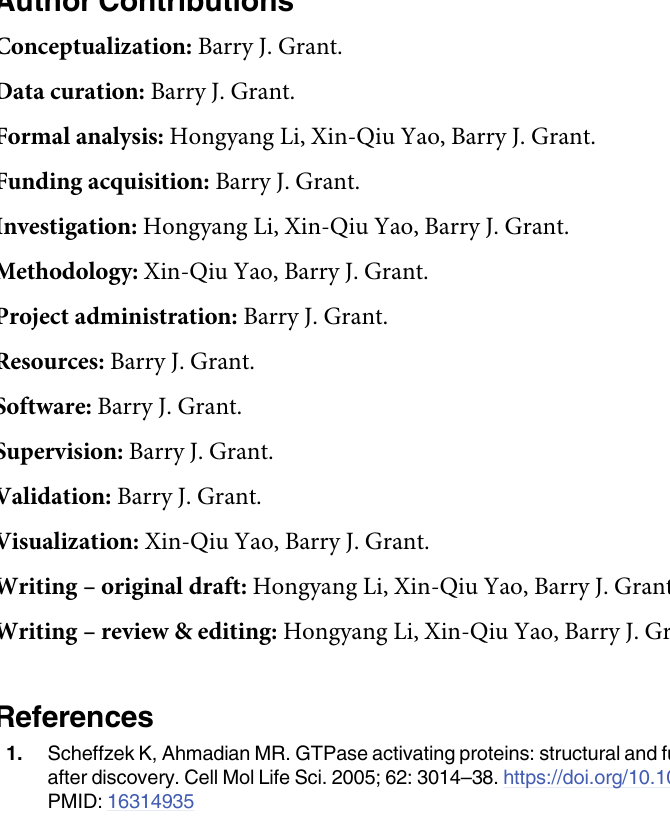
S2 Table. Analyzed crystallographic structures of G protein α subunit. S3 Table. Analyzed crystallographic structures of EF-Tu. S4 Table. Residue-wise contributions to inter-community couplings. The numbers repre- sent the residue-wise contributions to inter-community couplings. For example, the sum of correlations between residue M72 in SII and all residues in SIII/ α 3 is 1.19 (after filtering by contact map). The first row contains common counterpart residues (red) connecting SII and SIII/ α 3 in three proteins. The second row contains family-specific functional residues: residues in G α t and EF-Tu (blue) contribute to the dynamic correlations between SII and SIII/ α 3, whereas their counterparts in Ras (green) have no contributions. The third row contains G α t specific residue in SIII, which has no counterparts in the other two proteins. S5 Table. Summary of systems